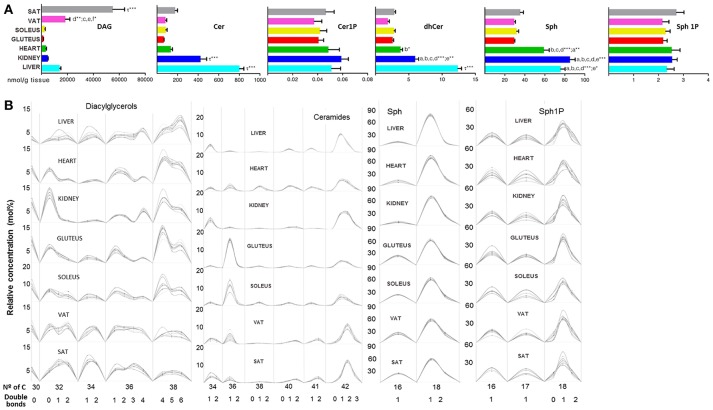
Second messenger lipid species within mammalian tissues detected by targeted lipidomic analysis. (A) Concentration of DAG, Cer, Cer1P, dhCer, Sph, and Sp1P. Values are expressed as mean ± SEM from 8 to 10 animals. Statistical analysis was one-way anova and post-hoc Tukey significance is represented in the bar chart, meaning a significantly different respect to SAT, b respect to VAT, c respect to soleus, d respect to gluteus, e respect to heart and f respect to kidney, g respect to liver, τ respect to all. *p < 0.05, **p < 0.01, and ***p < 0.001. (B) Relative concentration of lipids normalized per sample to the total abundance within this lipid class to obtain molar fractions. Each solid line indicated tissue from an individual rat. Gray vertical lines separate lipids by total number of acyl chain carbons. The number of double bonds is indicated below within each group.